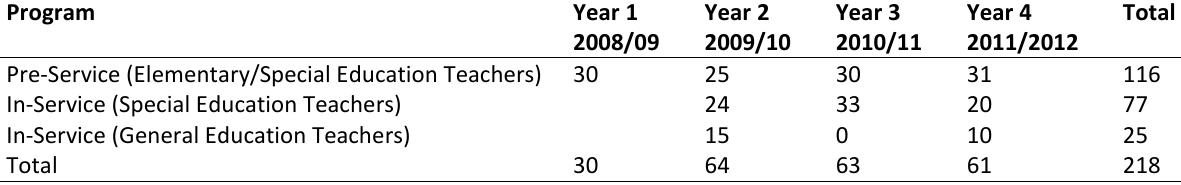
Table 1. Number of student participants by program and